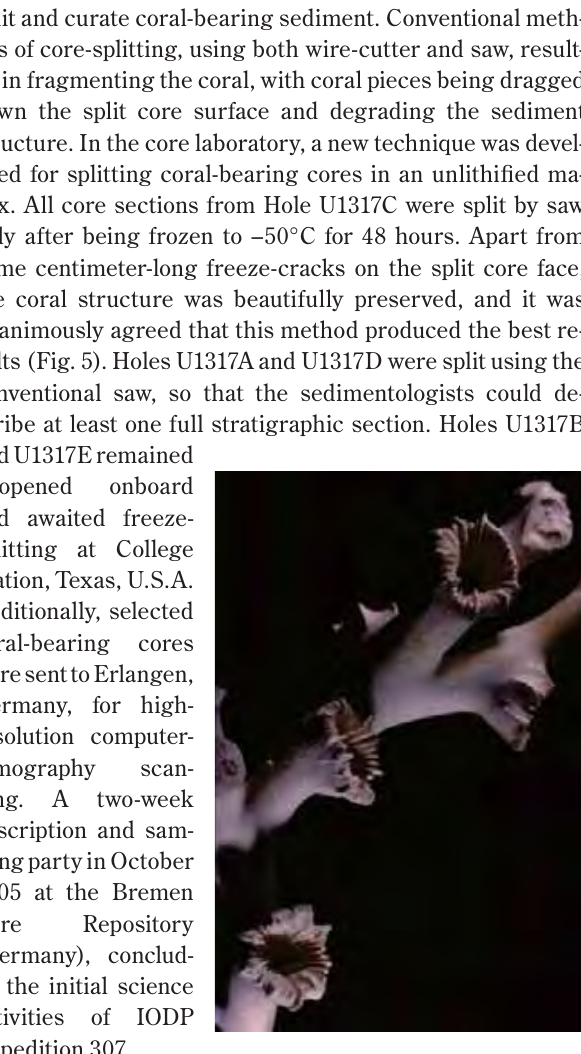
Figure 3. Micro-image of Lophelia